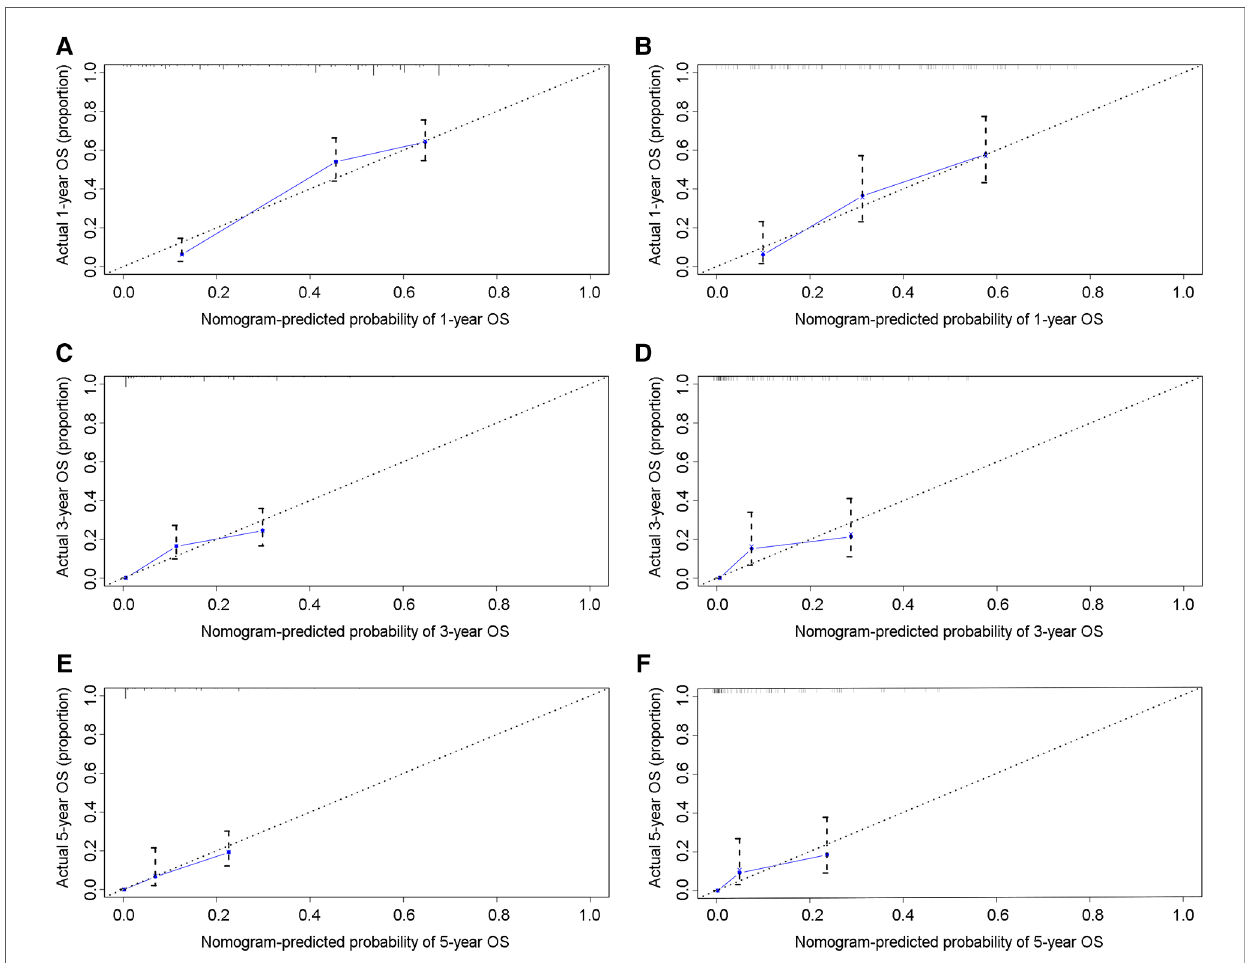
FIGURE 4 Calibration curves of the 1-, 3-, and 5-year OS of NEPC patients. 1-year ( A ), 3-year ( C ), 5-year ( E ) OS in training group; 1-year ( B ), 3-year ( D ), 5-year ( F ) OS in validation